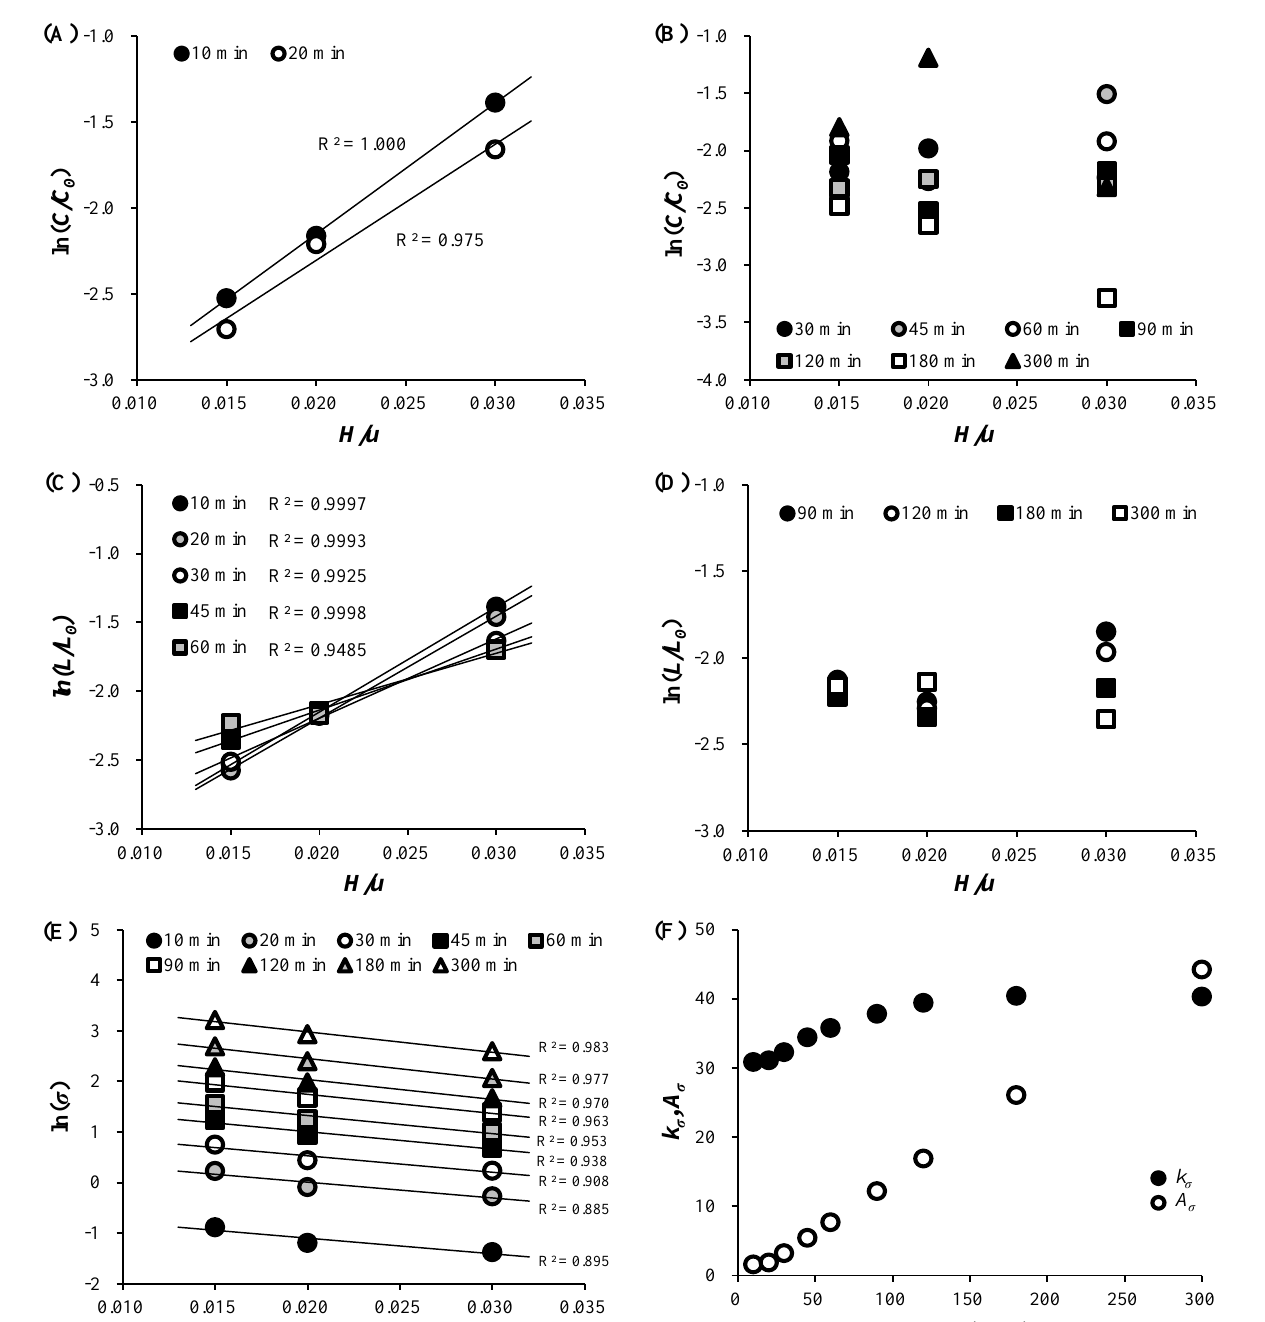
Figure 5. The k-C* model: ( A , B ) the corrrelation between ln ( C/C 0 ) and H/u during system operation times of ( A ) 10 − 20 min and ( B ) 30–300 min; ( C , D ) the correlation between ln ( L/L 0 ) and H/u during system operation times of ( C ) 10 − 60 min and ( D ) 90–300 min; ( E ) the correlation between ln ( σ ) and H/u ; ( F ) the time evolution of k σ and A σ .